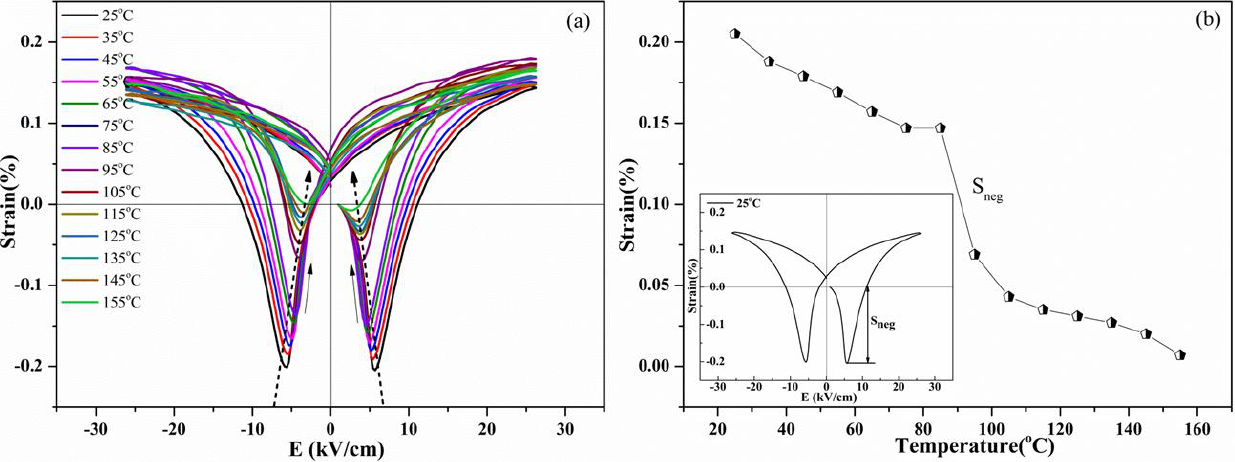
) neg in this neg